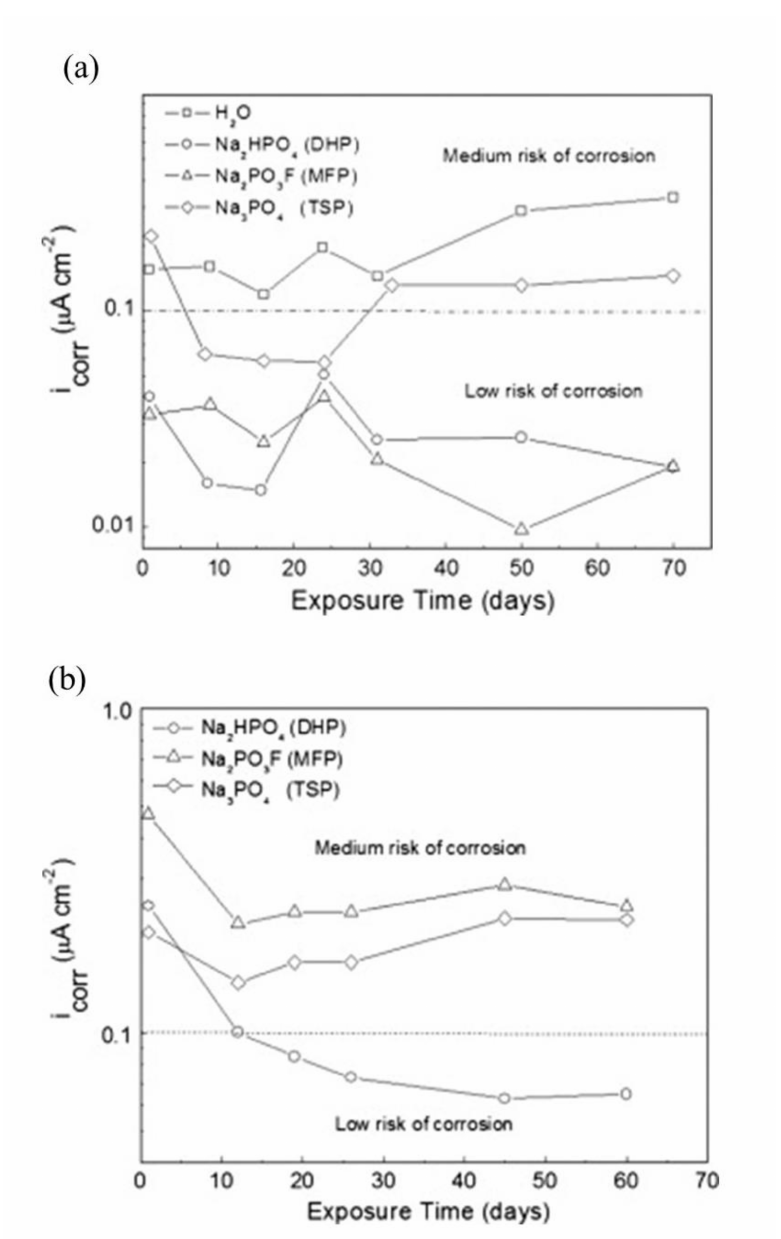
Figure 17. Corrosion current density ( i corr ) versus time for steel in the presence of: ( a ) migrating corrosion inhibitor (MCI) and ( b ) admixture corrosion inhibitor (ACI) bottom [43]. Reproduced with permission from Bastidas, D.M. et al., Cem. Conc. Comp.; published by Elsevier,